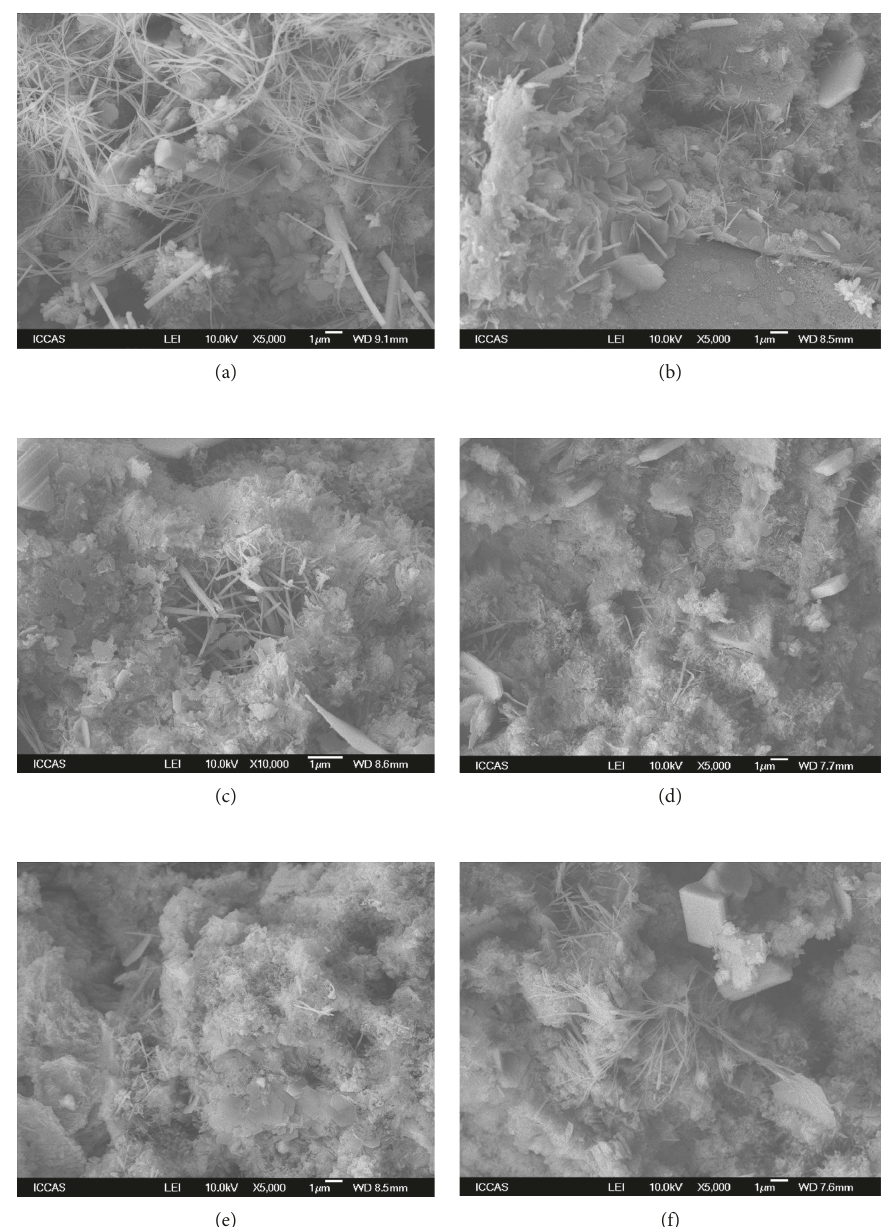
Figure 4: The hydration products morphology of different hardened cement at 3d. (a) Blank. (b) +0.05% EAC. (c) +0.05% DMO. (d) +0.05% TG. (e) +0.05% TMP. (f) +0.05%